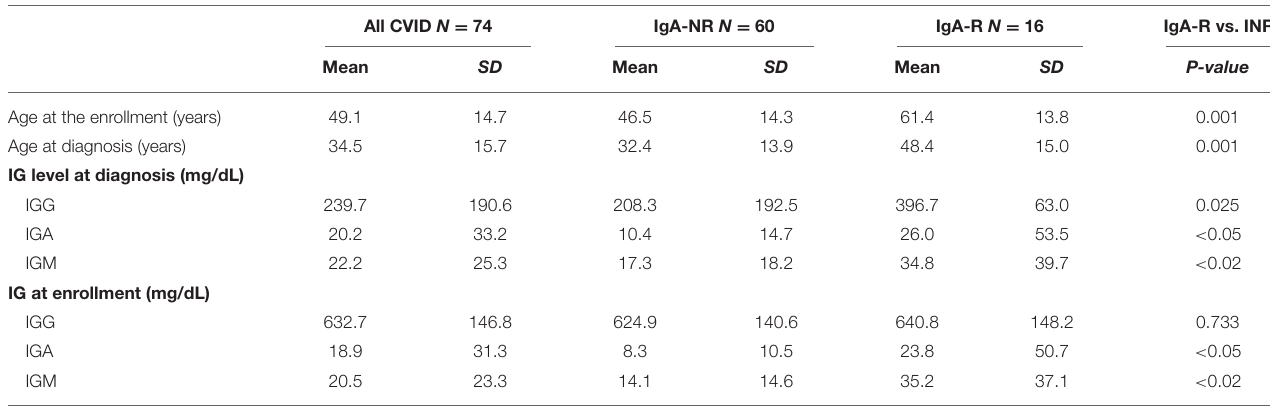
TABLE 1 | Characteristics of CVID patients at the enrollment.